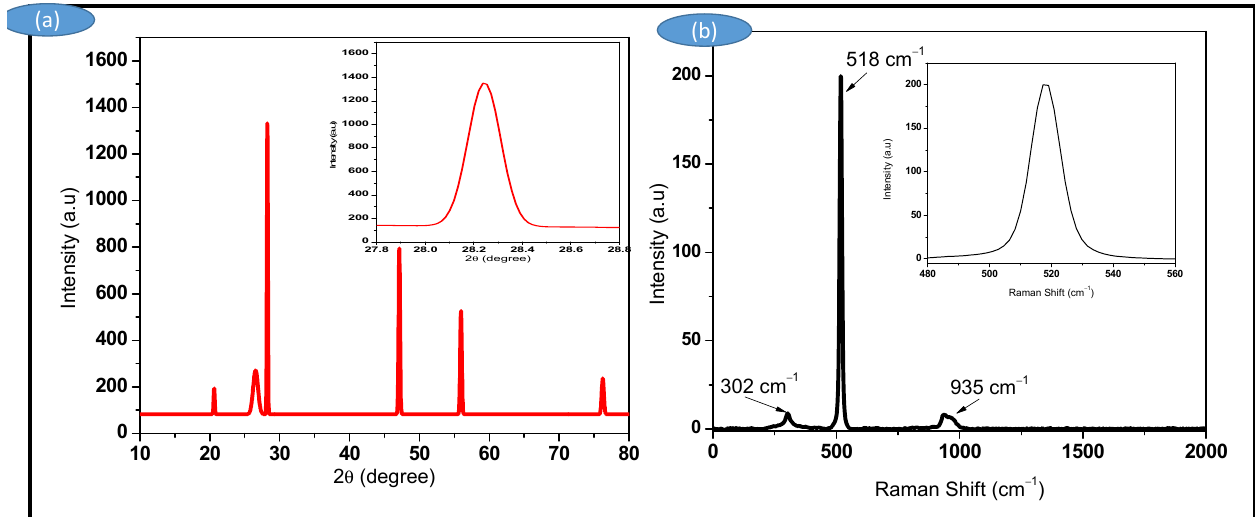
Figure 1. XRD pattern ( a ) and Raman spectrum ( b ) of SCBA nano silicon prepared by magnesiothermic reaction.